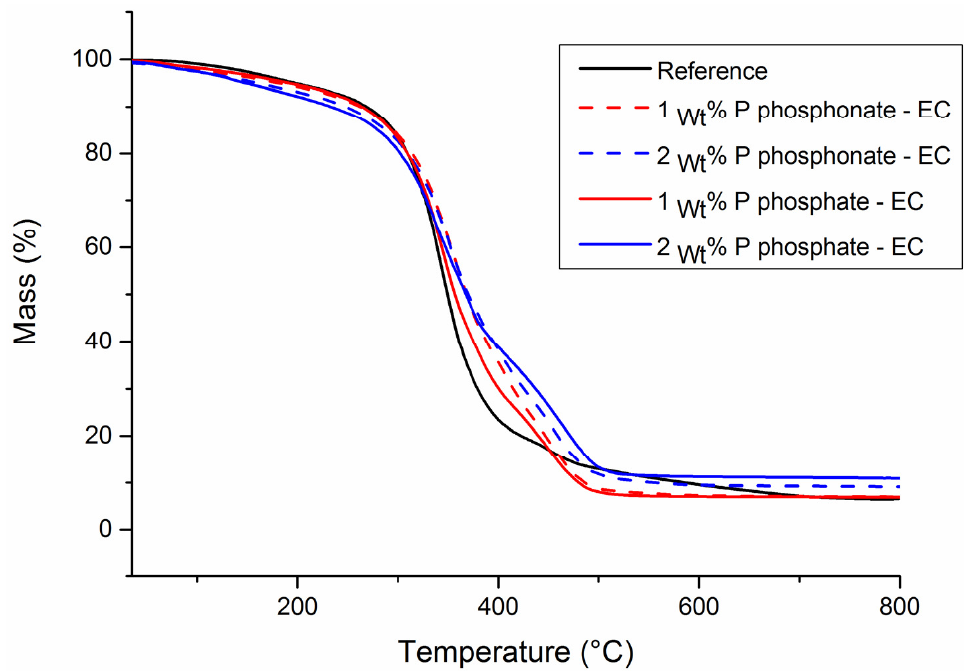
Figure 4. TGA thermograms of reference EC alkyd resin and PO x CR diluent EC alkyd resins. Table 3. Results of TGA analyses of reference EC alkyd resin and PO x CR diluent EC alkyd resins.